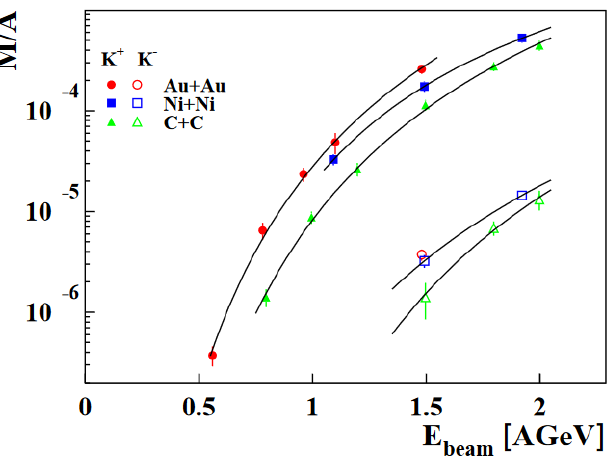
Figure 9. Multiplicities of K + (full symbols) and of K − mesons (open symbols) per mass number A of the collision system as a function of the beam energy. The lines represent fits to the data [41].